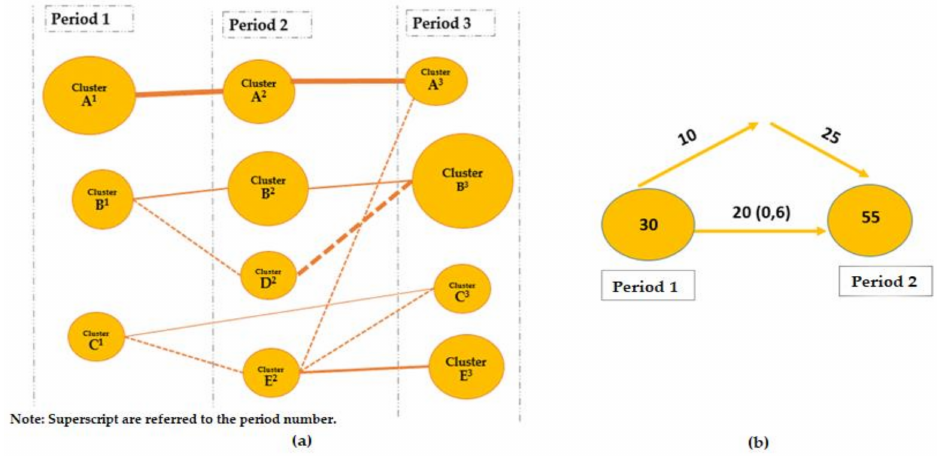
Figure 4. Thematic evolution map ( a ) and overlap map ( b ). Source: adapted from [42]. (B) To understand the situation of the most discussed topics in a given period, the strategy map (Figure 5b) was divided into four zones according to centrality and density.